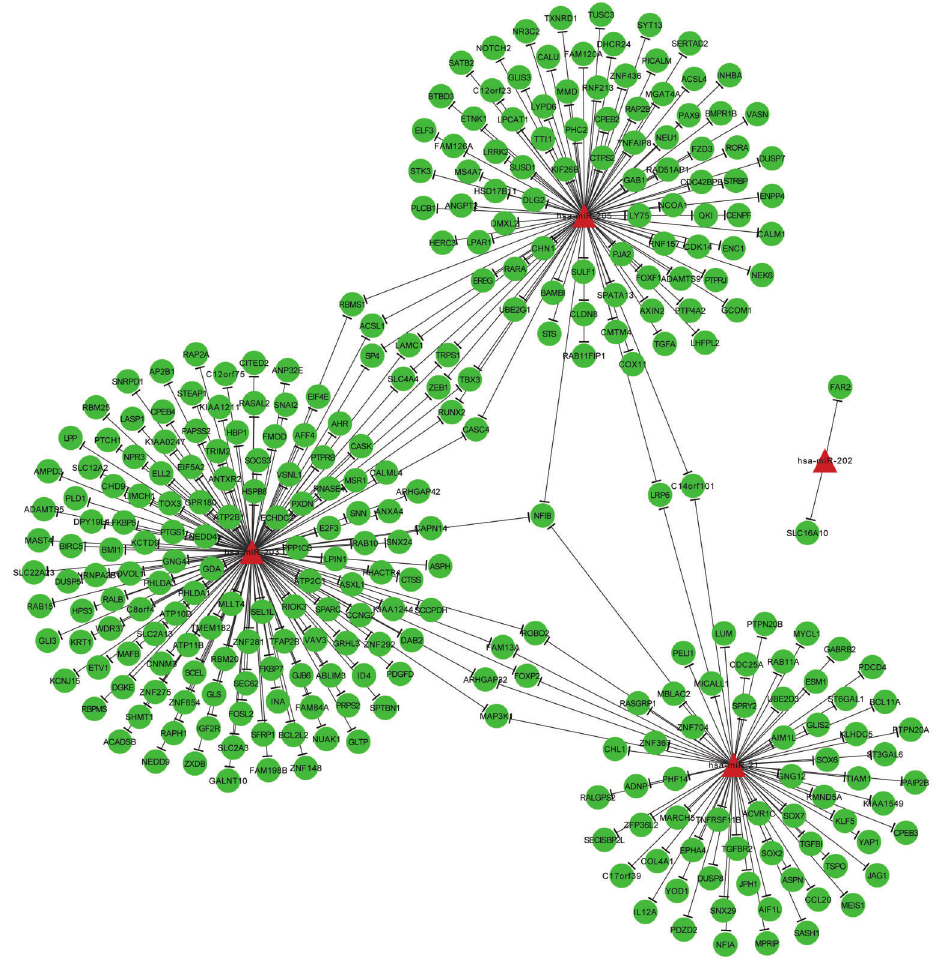
Figure 2. Regulatory network of selected miRNAs and their differentially expressed target genes in esophageal